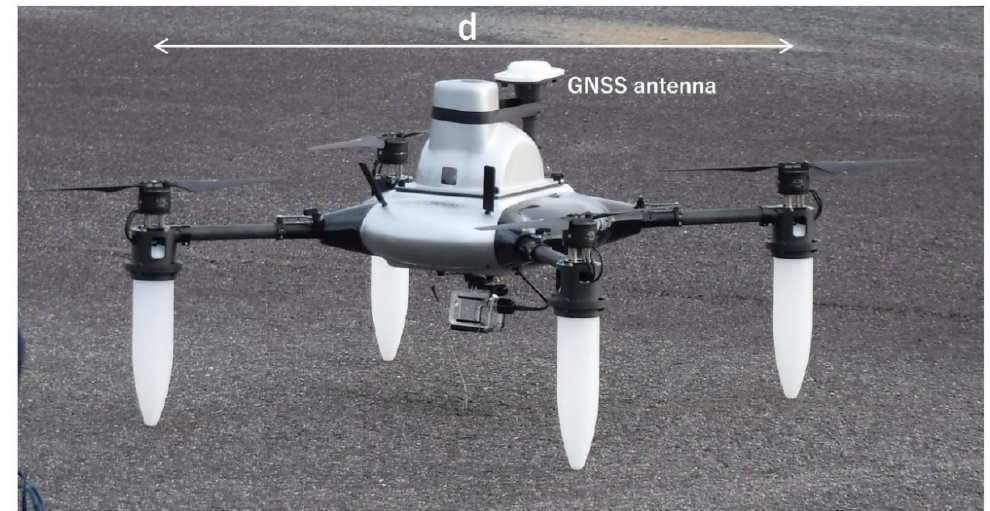
Figure 4. Sea-surface UAV.